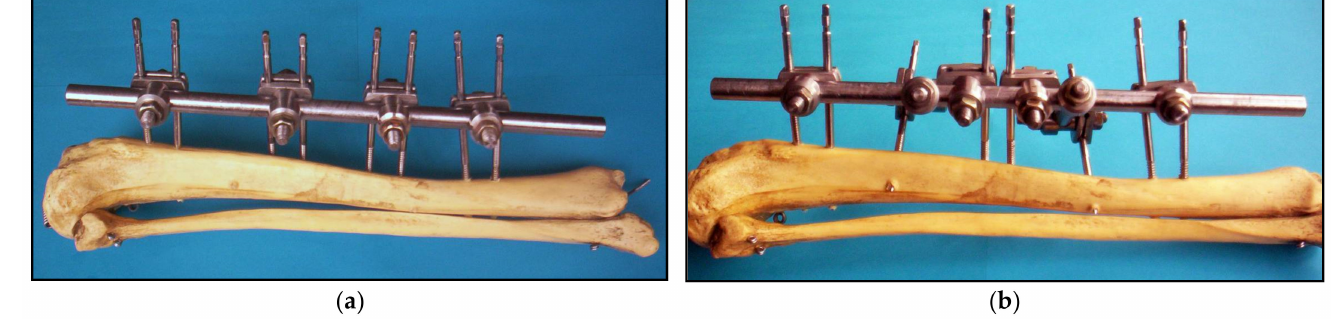
Figure 1. Sarafix fixation device with steel frame; ( a ) B50 configuration, ( b ) C50 configuration.